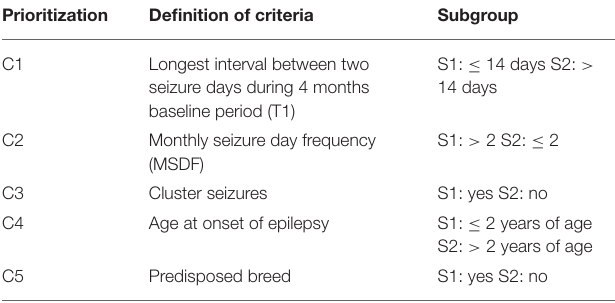
TABLE 1 | Matching